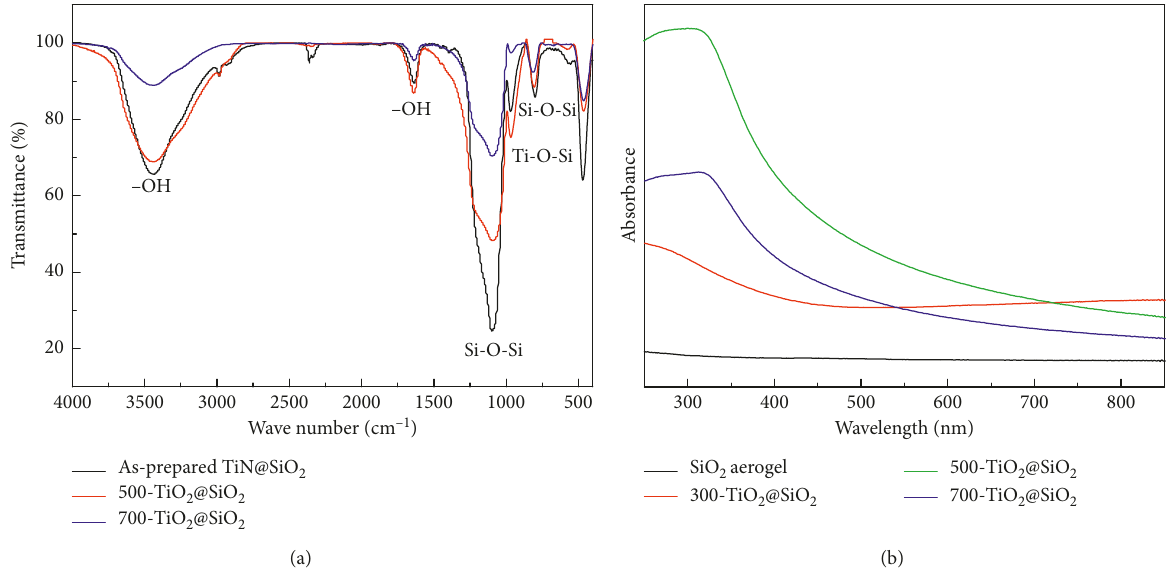
Figure 6: FT-IR (a) and UV-Vis (b) spectra of TiN@SiO 2 composite aerogels with different oxidation